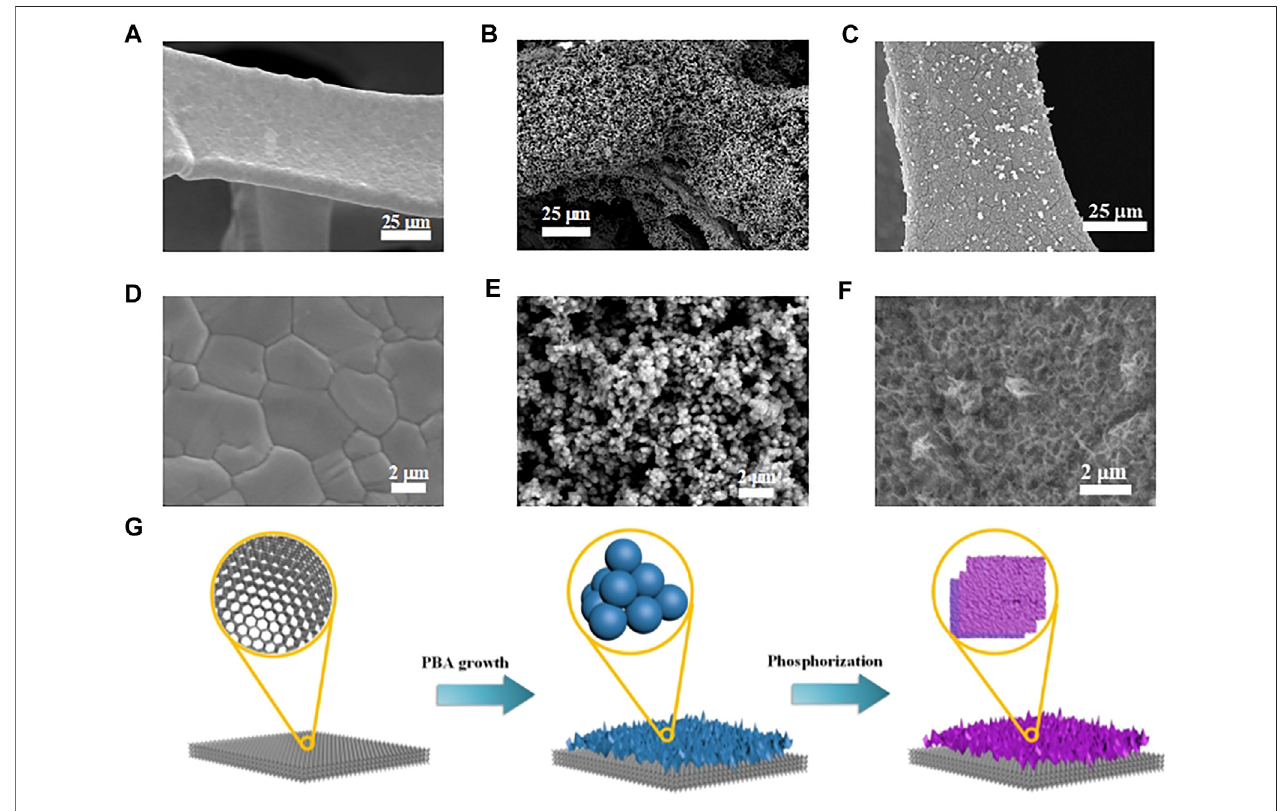
FIGURE 1 | (A) and (D) SEM images of cleaned NF in different magni fi cations. (B) and (E) SEM images ofFe-doped FeNi-PB on NF in different magni fi cations. (C) and (F) SEM images of FeNiOOH on NF in different magni fi cations. (G) Schematic for the synthesis processes of FeNiOOH on NF.